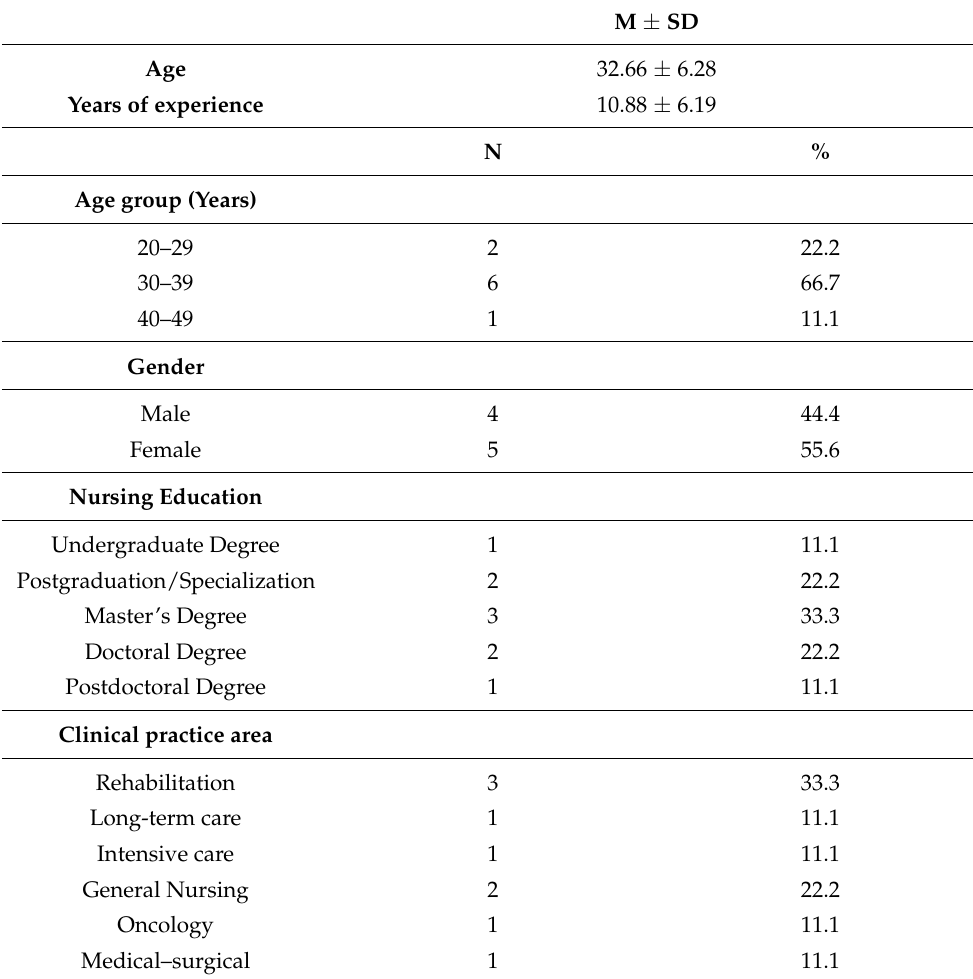
Table 1. Sociodemographic profile of the study participants who evaluated the sensor-based proto- types for PI prevention clothing. Coimbra, Portugal,